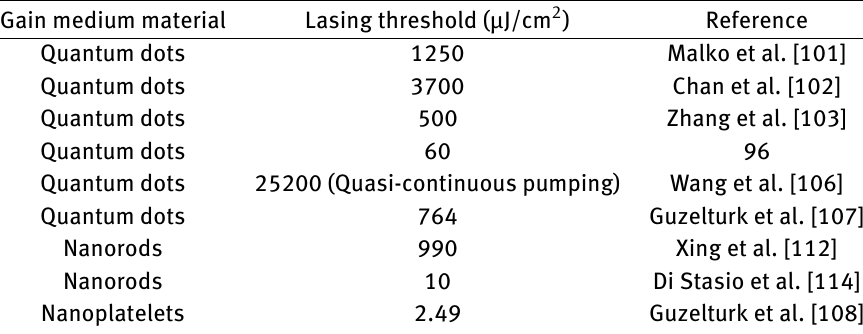
Table 4: Lasing thresholds of the colloidal lasers highlighted in this